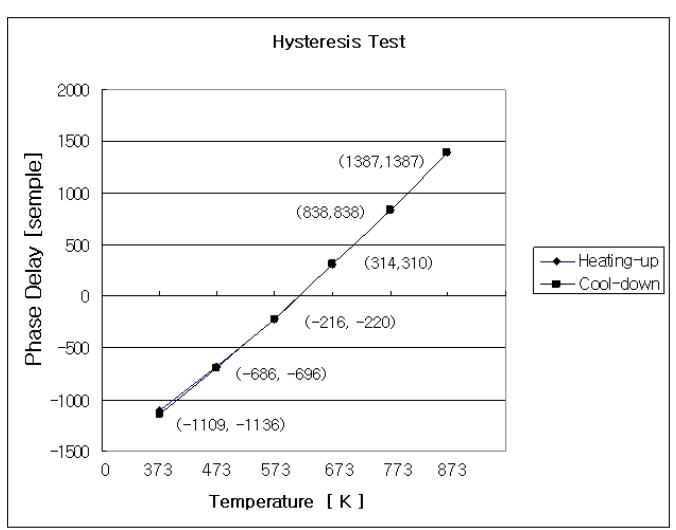
Figure 5 . Hysteresis